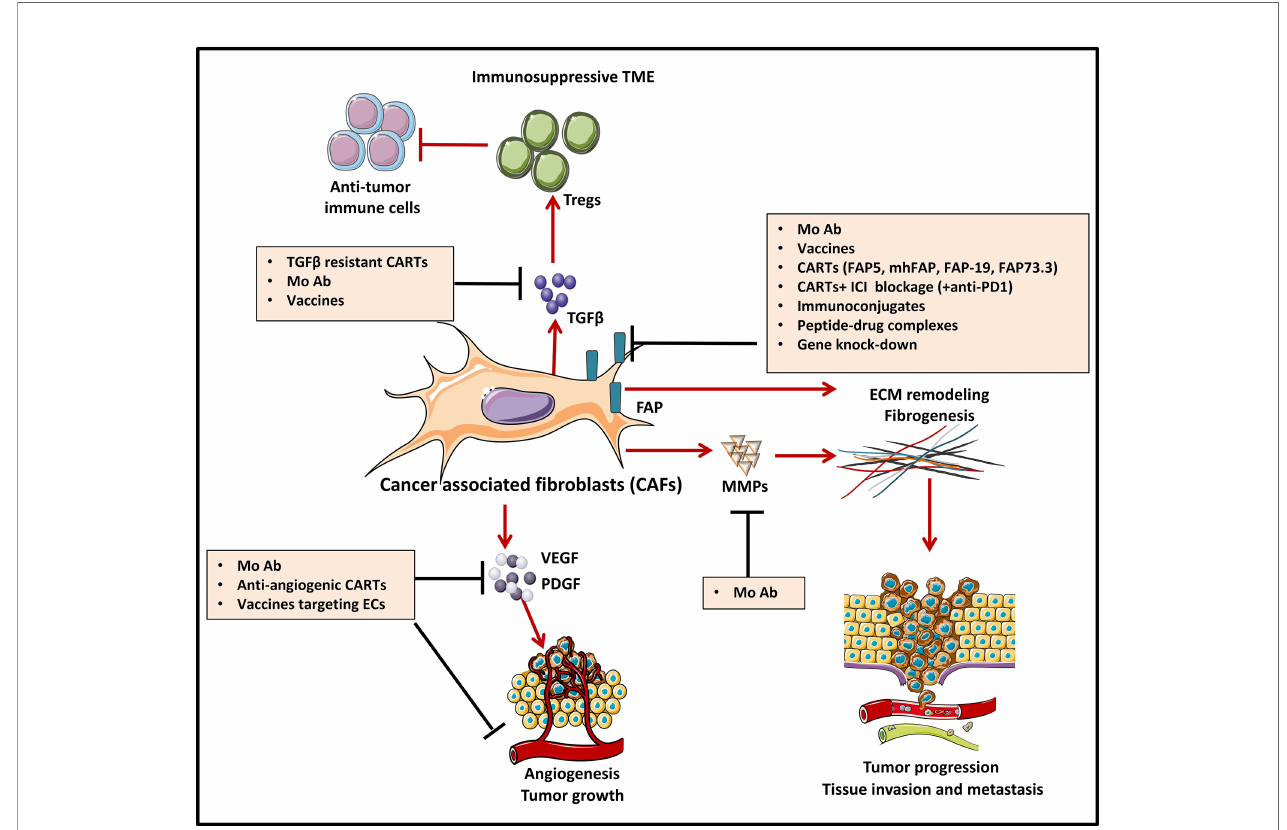
FIGURE 3 | Strategies to counteract protumorigenic effects of CAFs [Adapted from Kakarla et al. (148)]. Cancer associated fi broblasts (CAF)-directed anti-cancer therapies are one of the weapons of tumor targeting which is directed against the stromal compartment. Strategies depicted in this fi gure aim at inhibiting cancer associated fi broblasts (CAFs) functions and are based on targeting crucial signals and effectors of CAFs such as cytokines (TGF b ) and growth factor pathways (VEGF, PDGF … ). For instance, CAF-derived extracellular matrix proteins (MMPs) and associated signaling can be targeted with monoclonal antibodies (MAb), to induce stromal depletion and increase immune T cell in fi ltration. Blocking some targets like TGF b , can act both upstream and downstream, by blocking CAF formation and attenuating downstream signaling in CAFs that are already established. FAP targeting aims at blocking CAFs ability to exert tumor promoting effects in the TME. Targeting FAP can be done by using either MAb/antibody-drug conjugates, immunoconjugates or peptide-drug complexes, FAP-speci fi c CAR-T cells or strategies of gene-knock out. Some other strategies, not depicted in this fi gure aim at CAFs direct depletion or CAFs normalization towards an inactive phenotype.